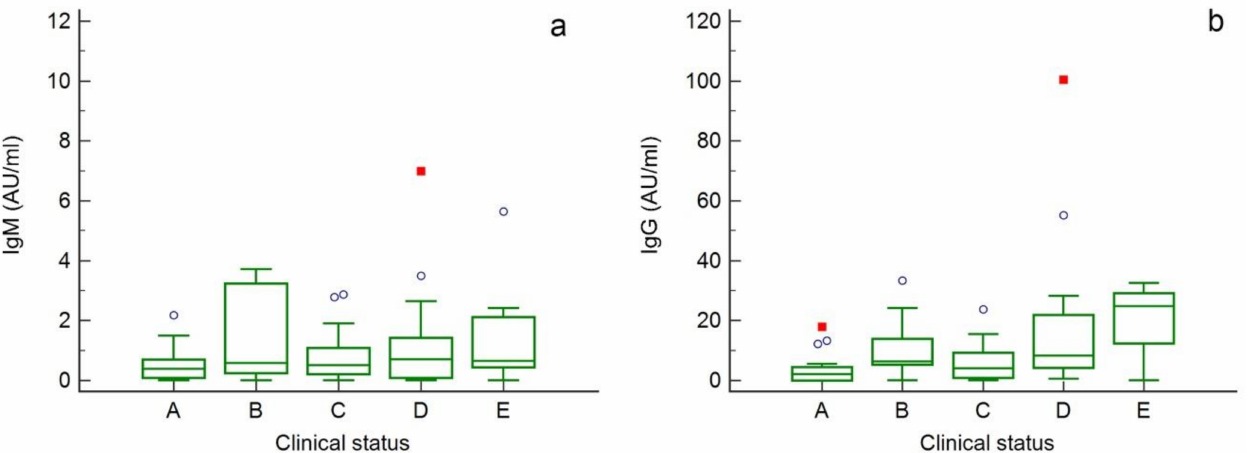
Figure 1. Box-and-whisker plots showing the distribution of IgM ( a ) and IgG ( b ) concentrations in the analyzed COVID-19 patients divided according to the severity of symptoms (A: asymptomatic; B: pauci-symptomatic; C: mild; D: severe; E: critical). Outliers were indicated in the figure as circles (outside values) and red squares (far out values).